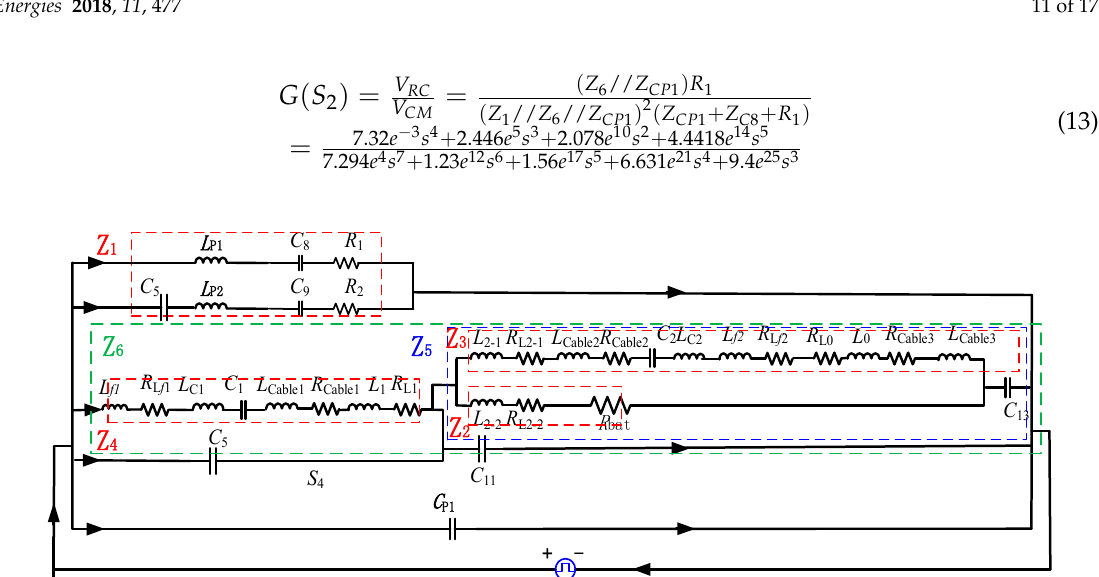
Figure 15. Analysis for CM interference: Equivalent circuit diagram.